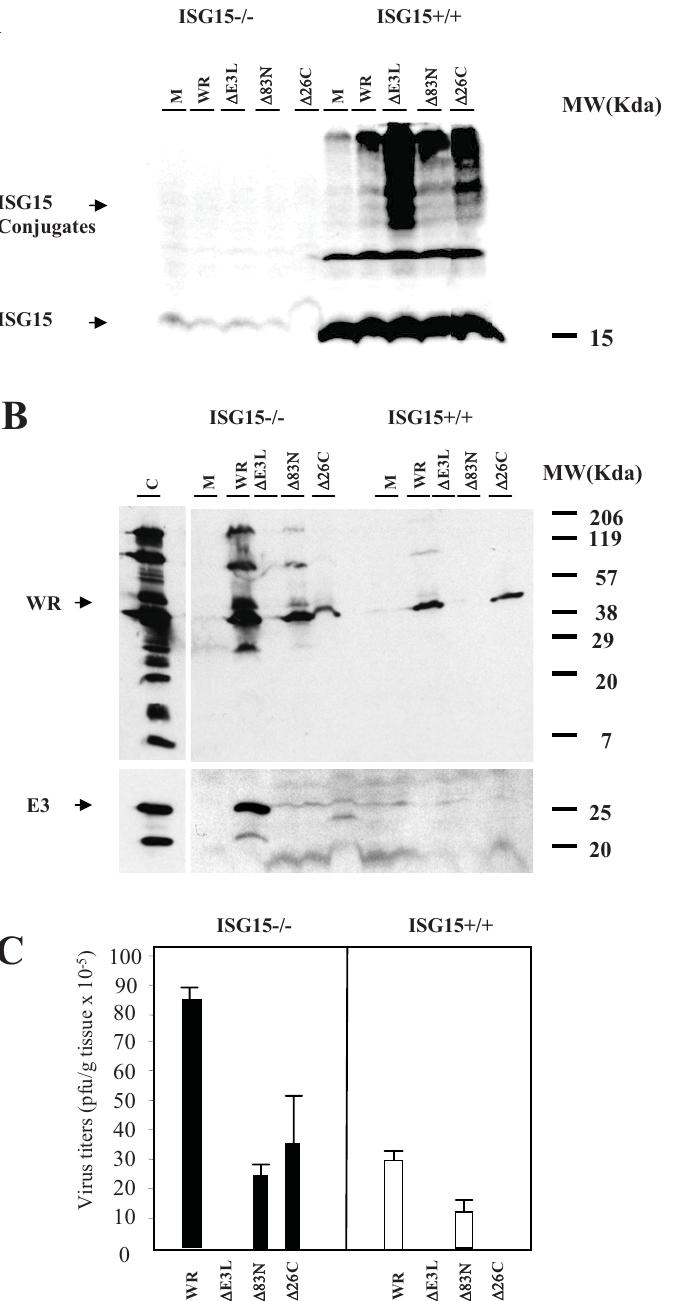
Figure 9. Viral replication of different VACV strains in infected ISG15 + / + and ISG15 2 / 2 mice. A–B . Western blot of ISG15 and of viral proteins in lung homogenates from ISG15 + / + and ISG15 2 / 2 mice. Animals were i.n, inoculated with purified WR (5 6 10 6 PFU/mouse) or VV D E3L (5 6 10 7 PFU/mouse) or VVE3L D 83N (5 6 10 7 PFU/mouse) or VVE3L D 26C (5 6 10 7 PFU/mouse) and immunoblots reacted with specific antibodies to ISG15 and to viral proteins. Each sample represents pools from 2 mice per group. C . Lung homogenates were titrated by plaque assay in BSC40 (for WR) or by immunostaining in BHK-21 cells (for VV D E3L). Each sample represents pools from 2 mice per group.